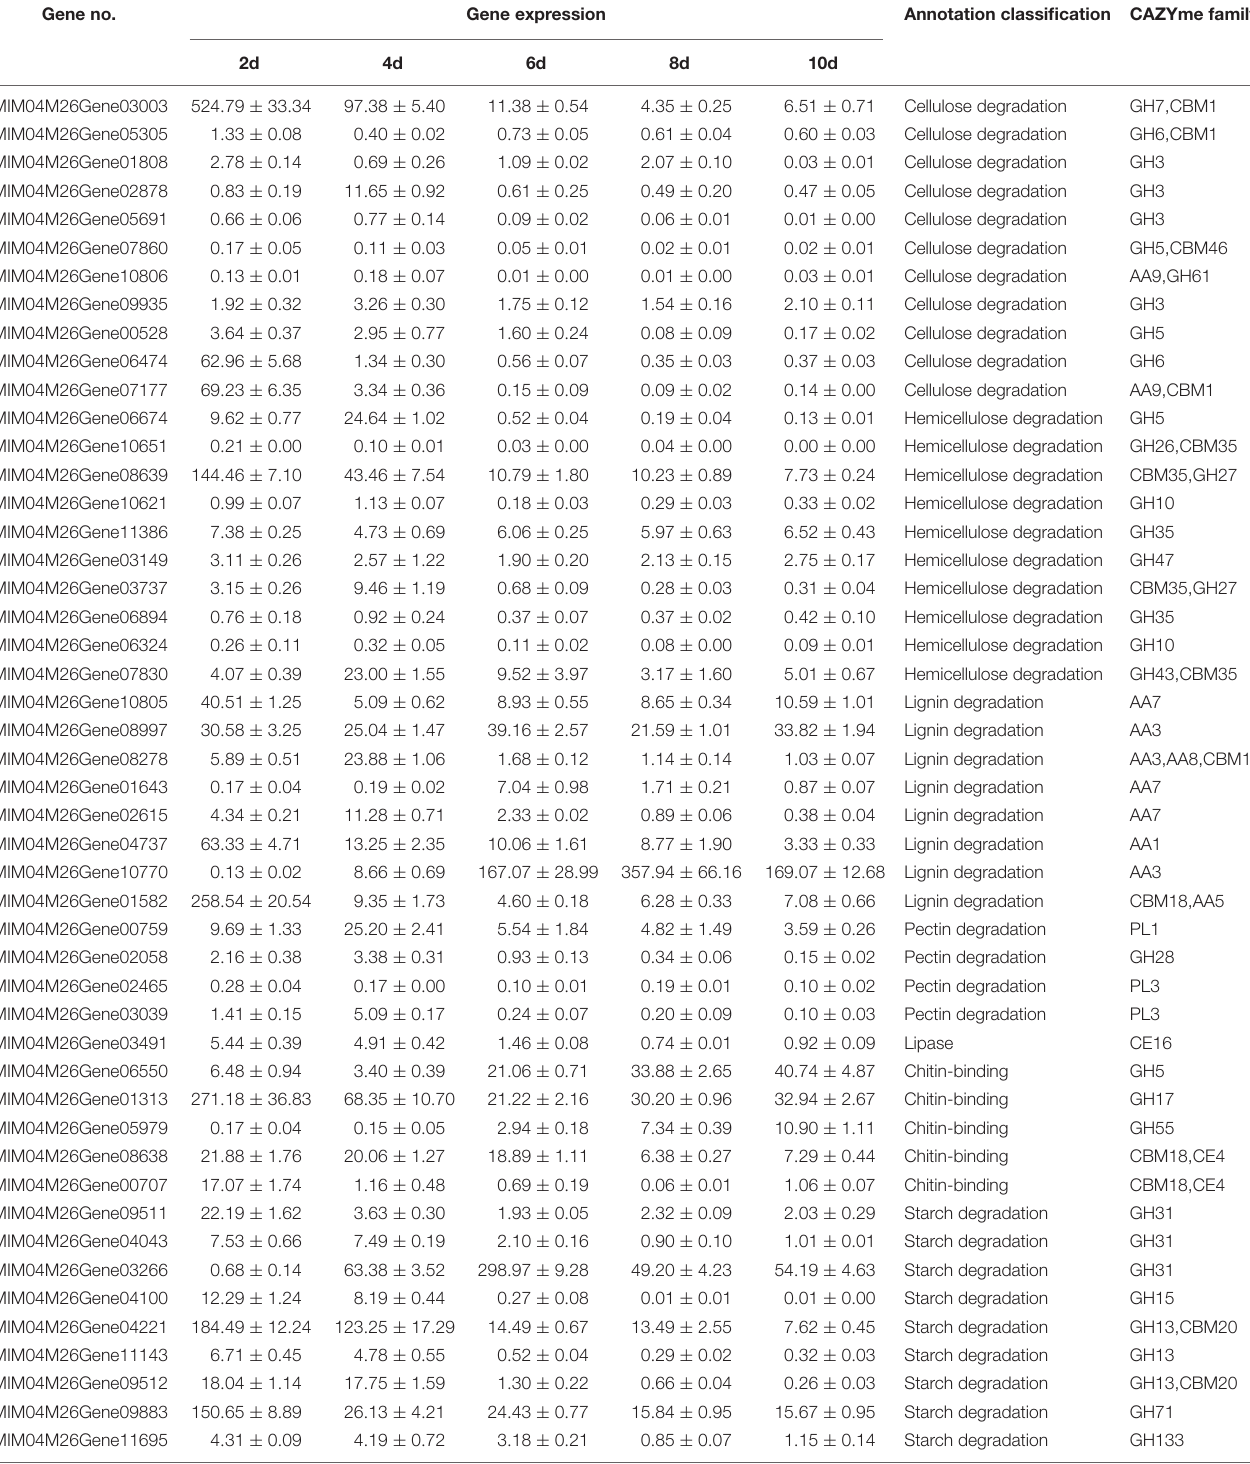
TABLE 1 | Expression patterns of the CAZYme genes in MIX medium of Morchella importuna . Gene no. Gene expression Annotation classification CAZYme